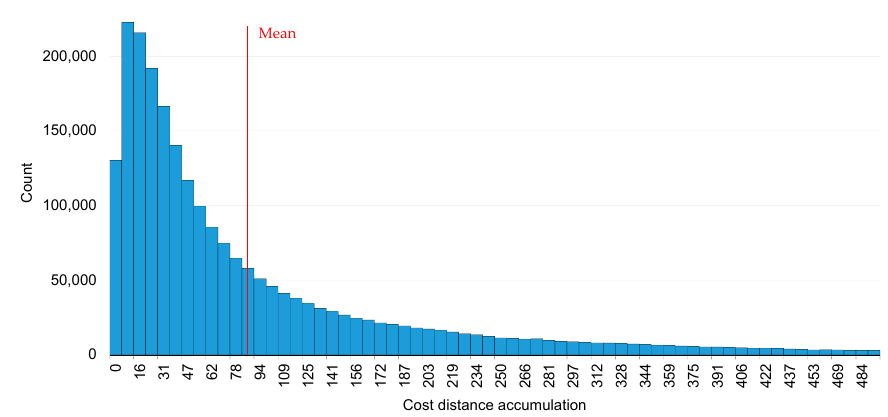
Figure 9. Distribution of cost distance accumulation values in the range greater than 0 to 500 within wetlands adjacent to rivers in the Gudenå drainage basin showing the mean value (value of 90) of cost distance accumulation (red vertical line), which we use as the threshold for our river valley bottom delineation. Count on the Y -axis represents the number of cost distance accumulation raster cells within each band.